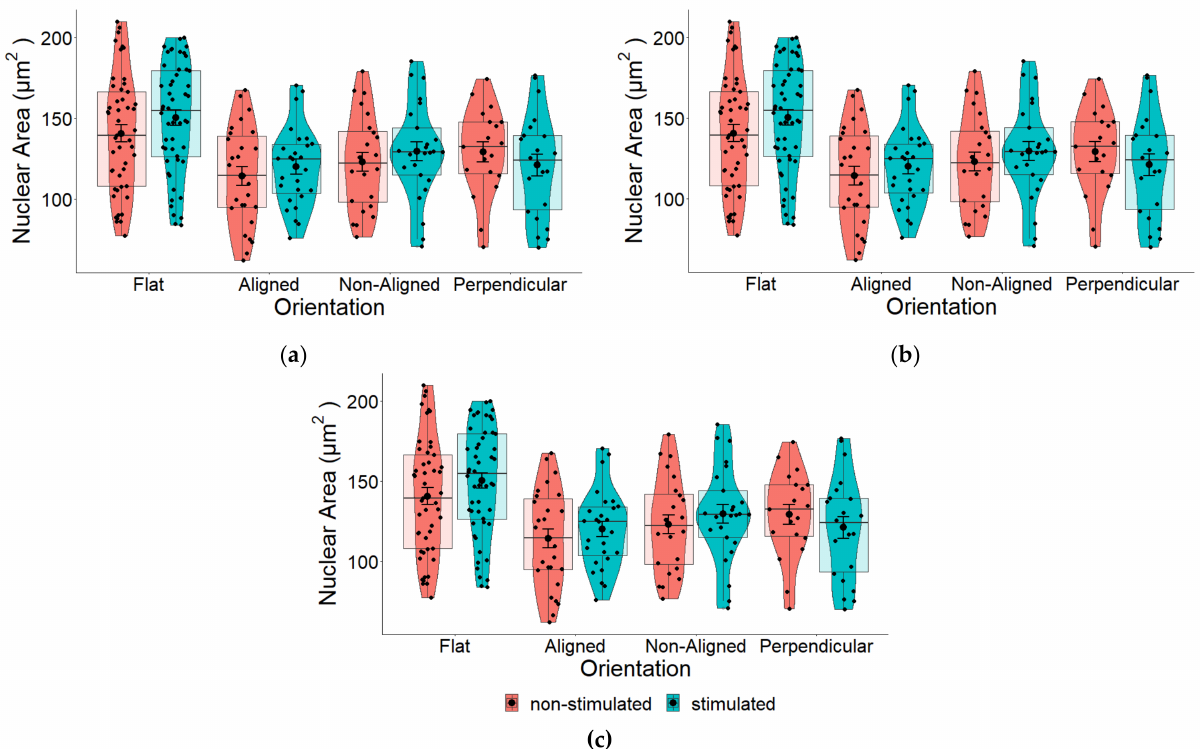
Figure 7. Pair-wise comparison of ( a ) total nuclear surface area, ( b ) major and ( c ) minor axes of SH-SY5Y cells following ES based on location (Figure 3) of cells. There were no significant differences in nuclear area based on location of cells within the EF. Left n = 82, middle n = 82, right n = 81.